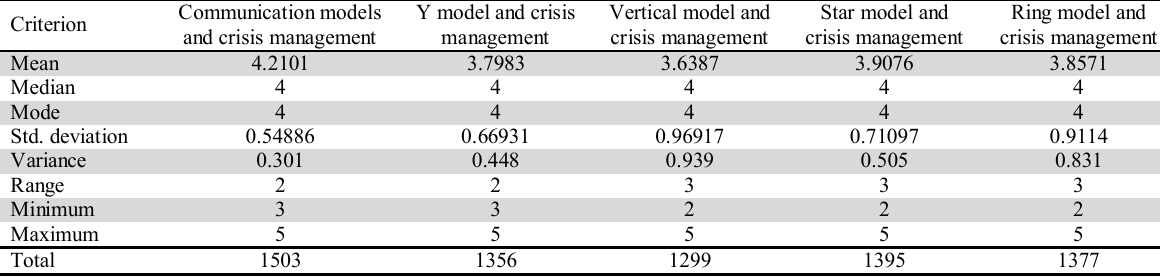
Some basic statistics associated with two